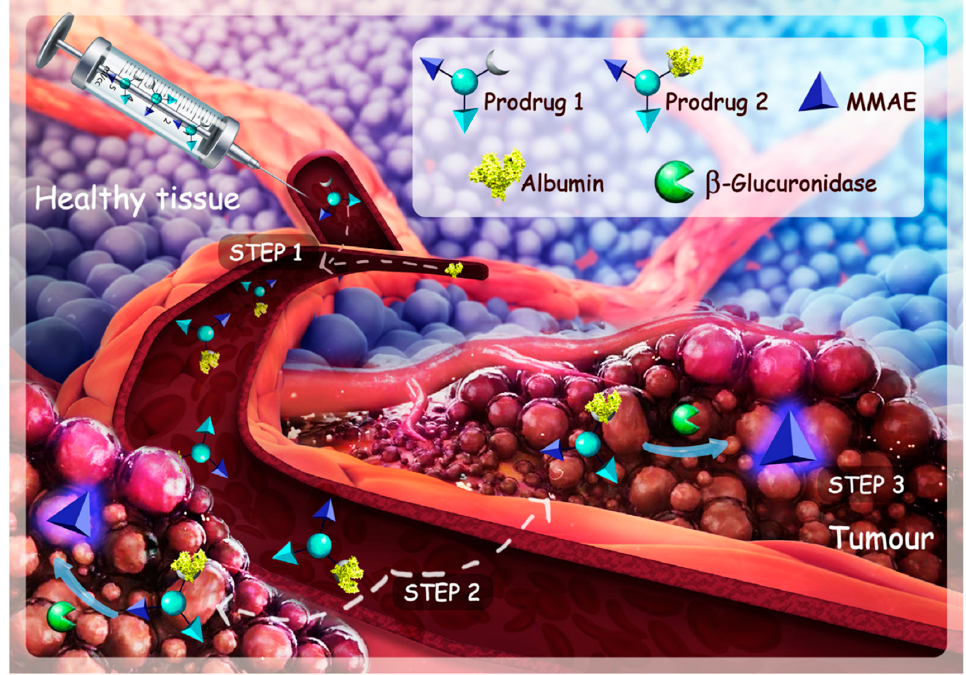
Figure 6. The main GSH-responsive progress in the tumor. Reprinted with permission from Ref. [59]. Copyright 2017, Papot